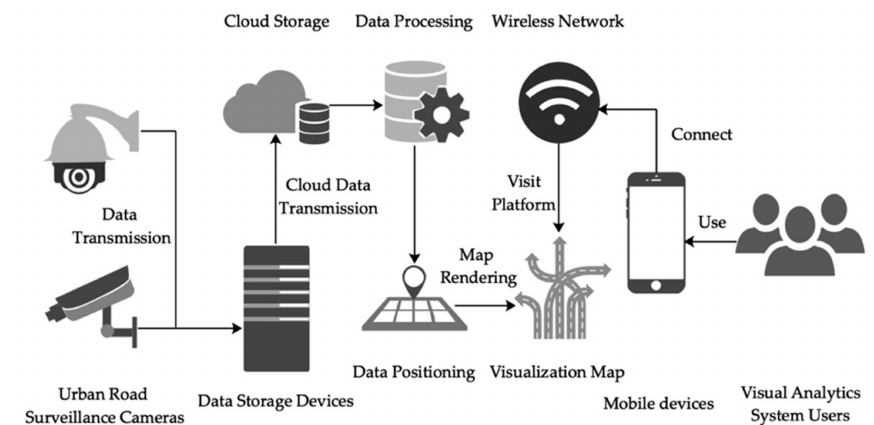
Figure 5. The architecture of Visualization system.